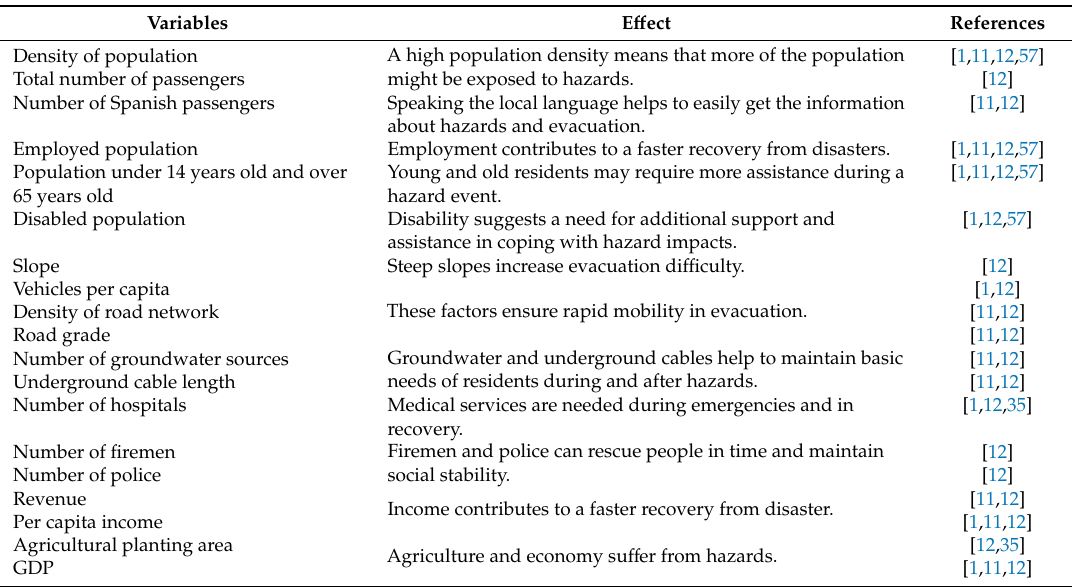
Table 5. Variables selected for assessing social